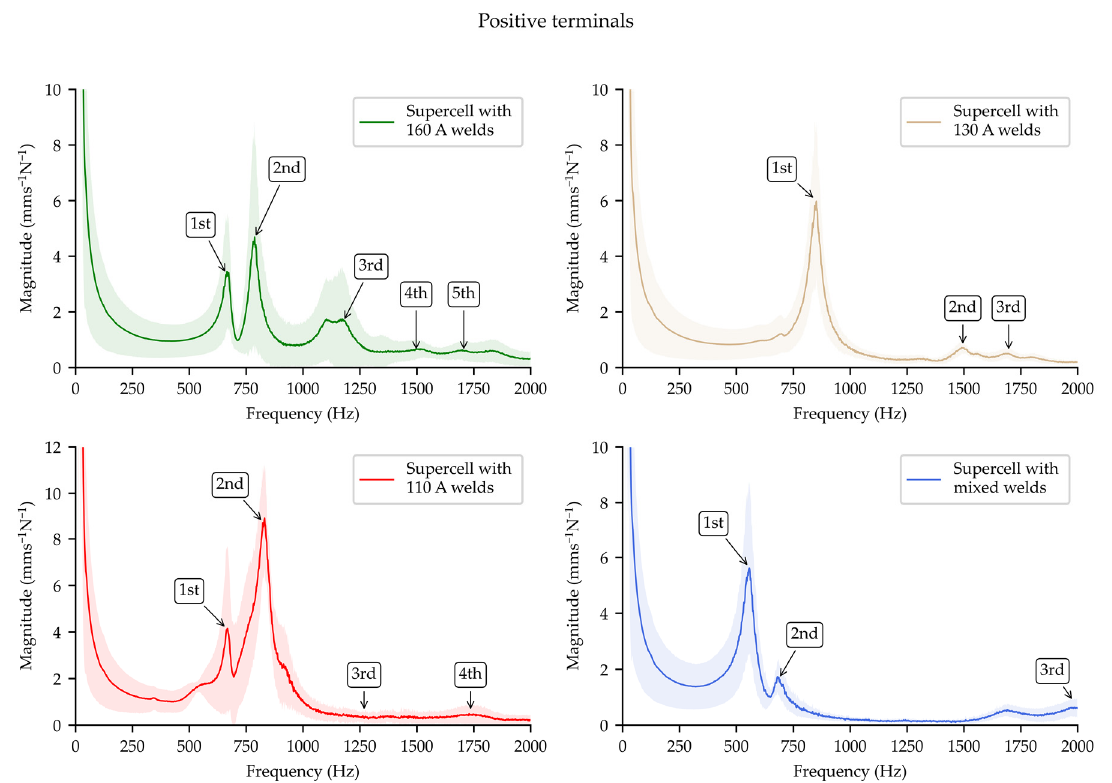
Figure 17. Mean spectra obtained from the tabs at the positive terminals of the supercells. Each line in bold is the mean of 10 FRFs obtained from the centers of each of the welded tabs. Shaded regions represent one standard deviation from the mean of the magnitude. Annotations mark the resonance frequencies of mode shapes obtained by EMA (of the first, second, third, fourth, and fifth mode